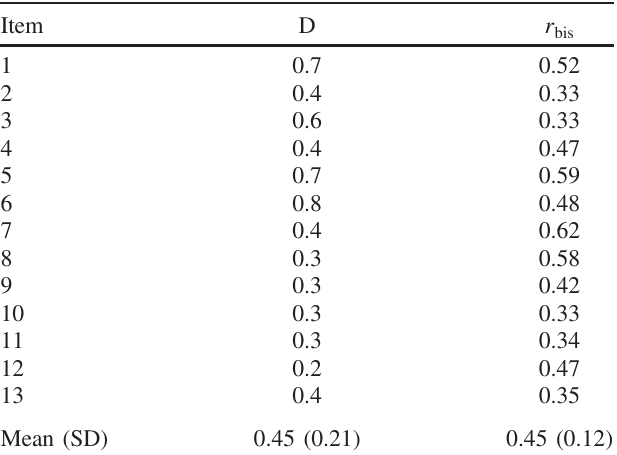
for the second bis